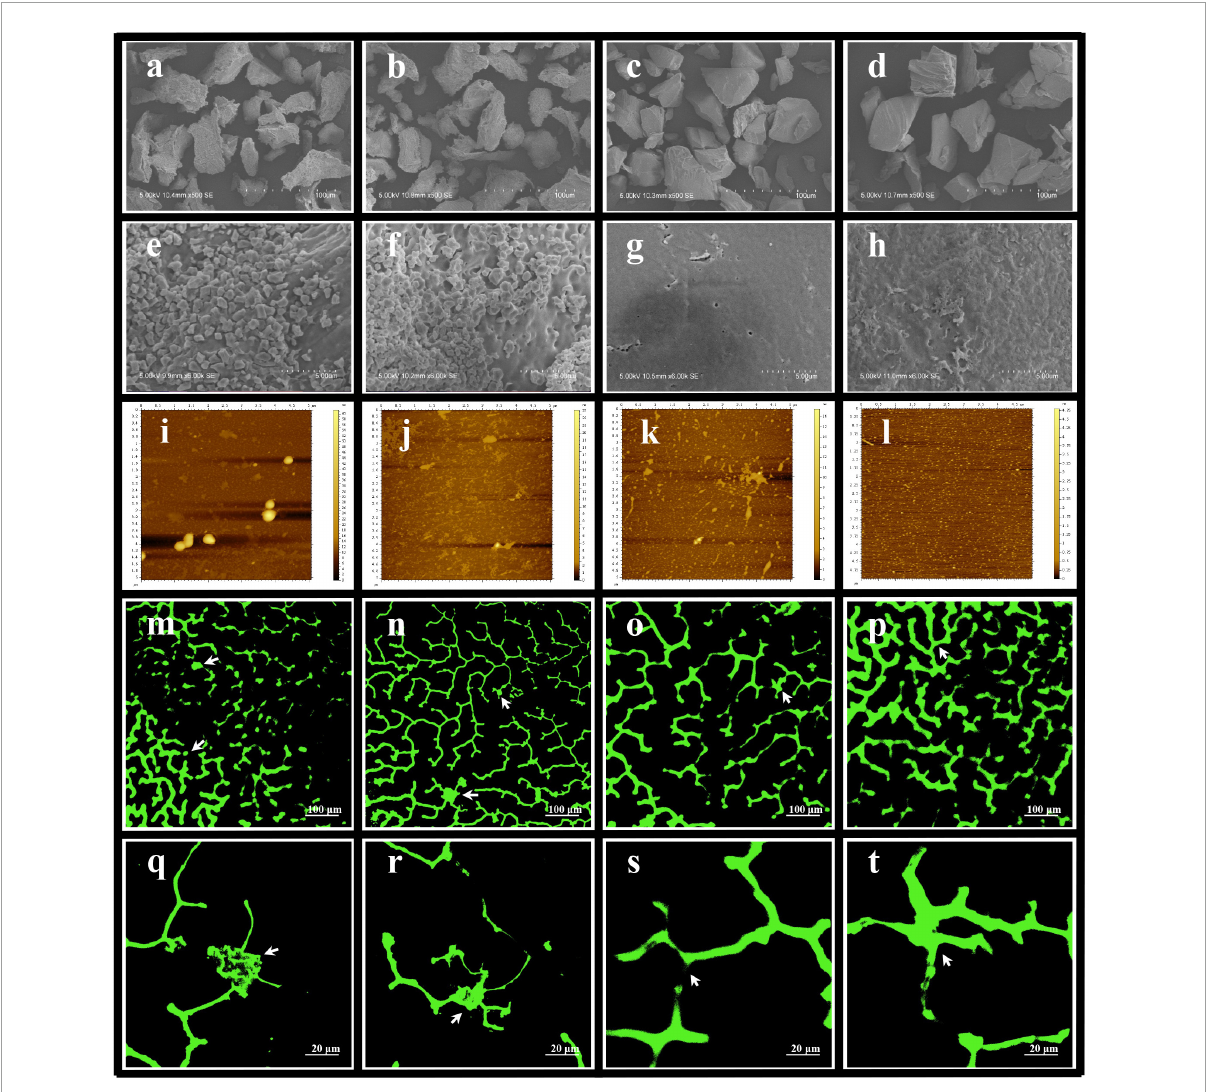
FIGURE11 Effect of steaming and sulfur fumigation on the morphology of Gastrodia elata starch granules. Scanning electron microscopy (SEM) images of G. elata starch granules [ (a,e) nonsteam and nonsulfur fumigation treatment (NSt-NSf); (b,f) nonsteam and sulfur fumigation treatment (NSt-Sf); (c,g) steam and nonsulfur fumigation treatment (St-NSf); (d,h) steam and sulfur fumigation treatment (St-Sf)]. AFM images of G. elata starch granules after gelatinization for 10 min of NSt-NSf (i) , NSt-Sf (j) , St-NSf (k) , St-Sf (l) . Confocal experimental images of G. elata starch granules after gelatinization for 10 min [ (m,q) NSt-NSf; (n,r) NSt-Sf; (o,s) St-NSf; (p,t)